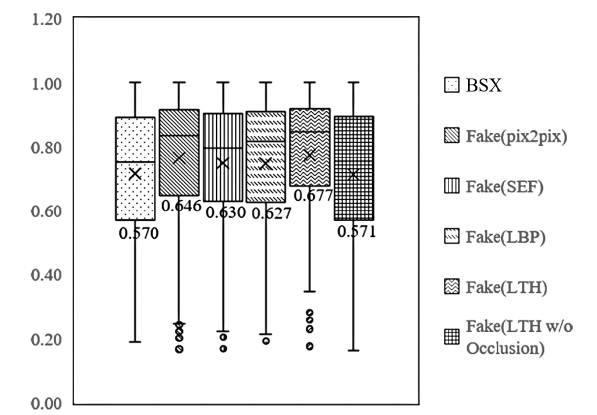
Figure 12. Distribution of mIoU of segmentation according to the texture